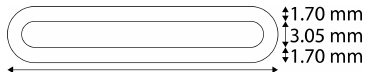
Figure 2. Dimensions of the machined ferromagnetic foil used in the racetrack